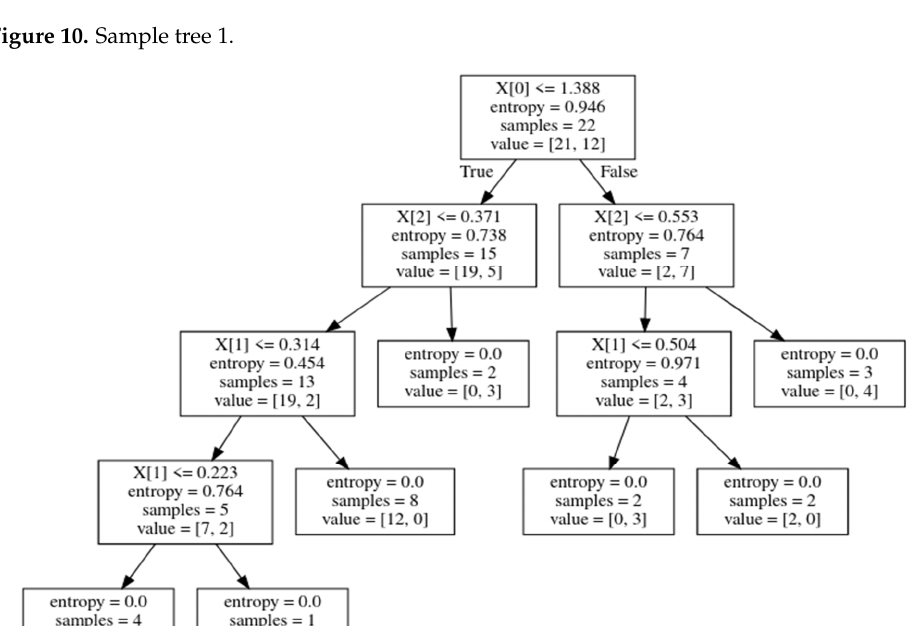
Figure 10. Sample tree 1.